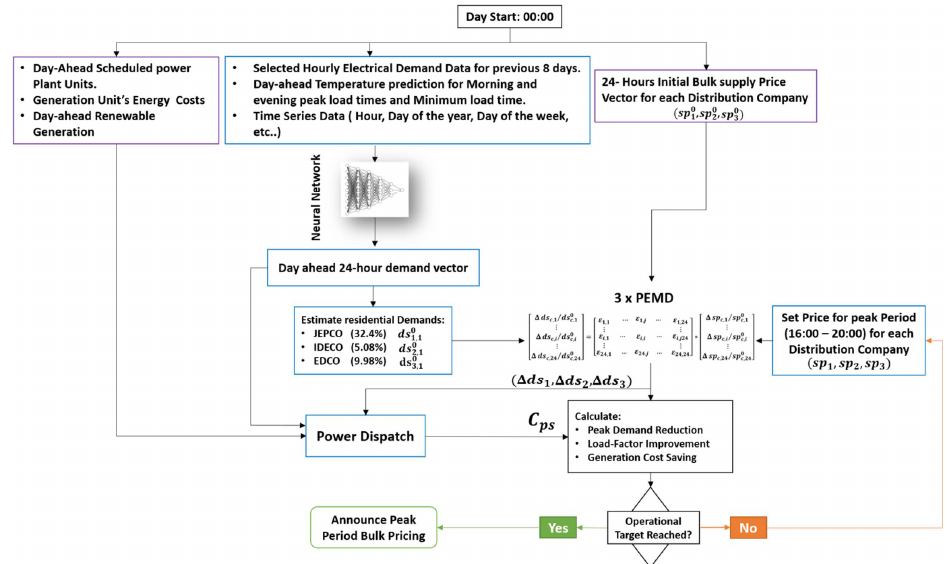
Figure 18. Applied Day-ahead DR Model for a selected day.